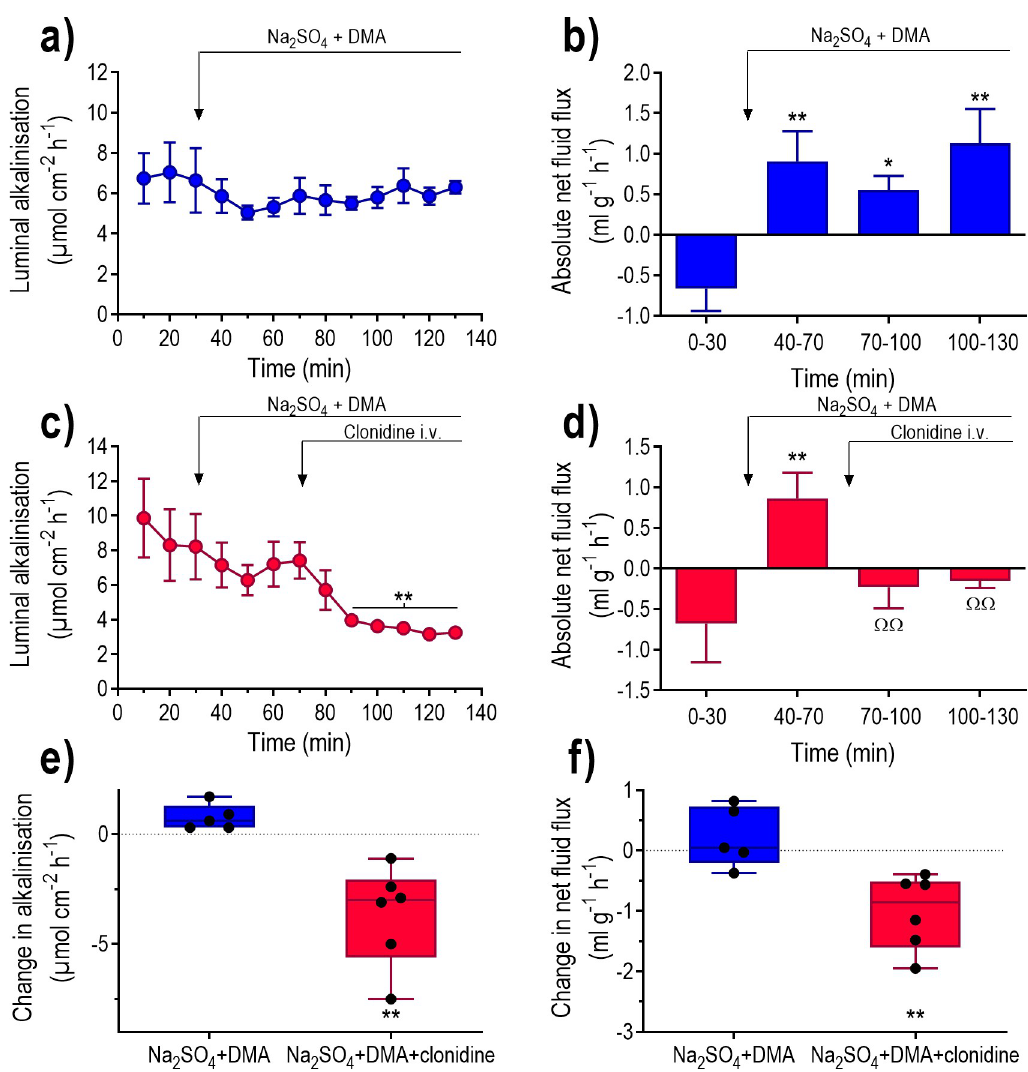
Fig 8. The effects of clonidine on fluid flux and luminal alkalinisation in rat duodenum perfused with a Cl - -free + DMA solution. Duodenum was perfused with isotonic saline for 30 min and then an isotonic Na 2 SO 4 plus dimethylamiloride (DMA) solution for 100 min (Fig 1). Effects on (a and c) luminal alkalinisation and (b and d) transepithelial net fluid flux were determined in the absence and presence of i.v. infusion of clonidine at a dose of 10 μ g kg -1 h -1 . Changes in (e) luminal alkalinisation and (f) transepithelial net fluid flux between 110–130 min and 50–70 min (Na 2 SO 4 plus DMA plus clonidine vs. Na 2 SO 4 plus DMA alone). Values are means ± SEM or box plots with all individual points. Fig b) and d) � P < 0.05 and �� P < 0.01 compared with values at 0–30 min. Fig (c) �� P < 0.01 compared with values at 40–70 min. Fig (c) FF P < 0.01 compared with compared with values at 50–70 min. Fig (e) and (f) �� P < 0.01 compared with animals treated with Na2SO4 plus DMA